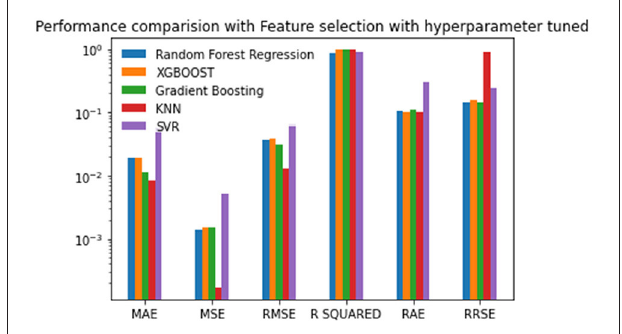
FIGURE 6 | Performance comparison graph of regression techniques with feature selection algorithm and with hyperparameter tuning.